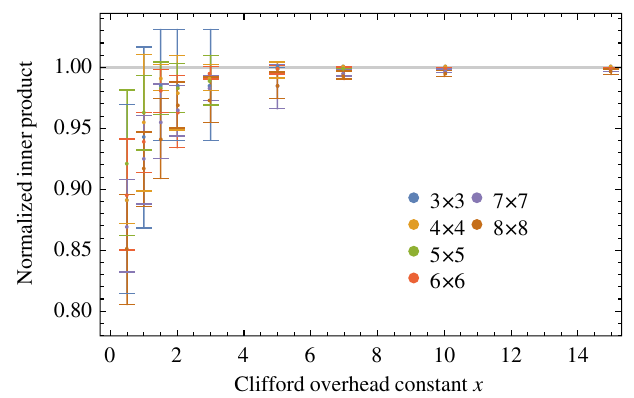
FIG. 16. Normalized inner product q x . q 20 /( | q x || q 20 | ) between quasiprobability distributions that are obtained in the learning part of the protocol, as described in Sec. VII, with Clifford over- head constants c = x ( q x ) and c = 20 ( q 20 ). We plot the inner product for different circuit sizes nxn , where n is both the number of qubits and the number of layers of two-qubit gates. Here we have chosen q 20 as the reference for other distributions, assum- , which is obtained ing that q 20 deviates only marginally from q (cid:7) opt from the full training set T . This allows us to estimate the impact on errors due to the truncation of the training set and, hence, lets us choose a suitable Clifford overhead constant c for our simulations.